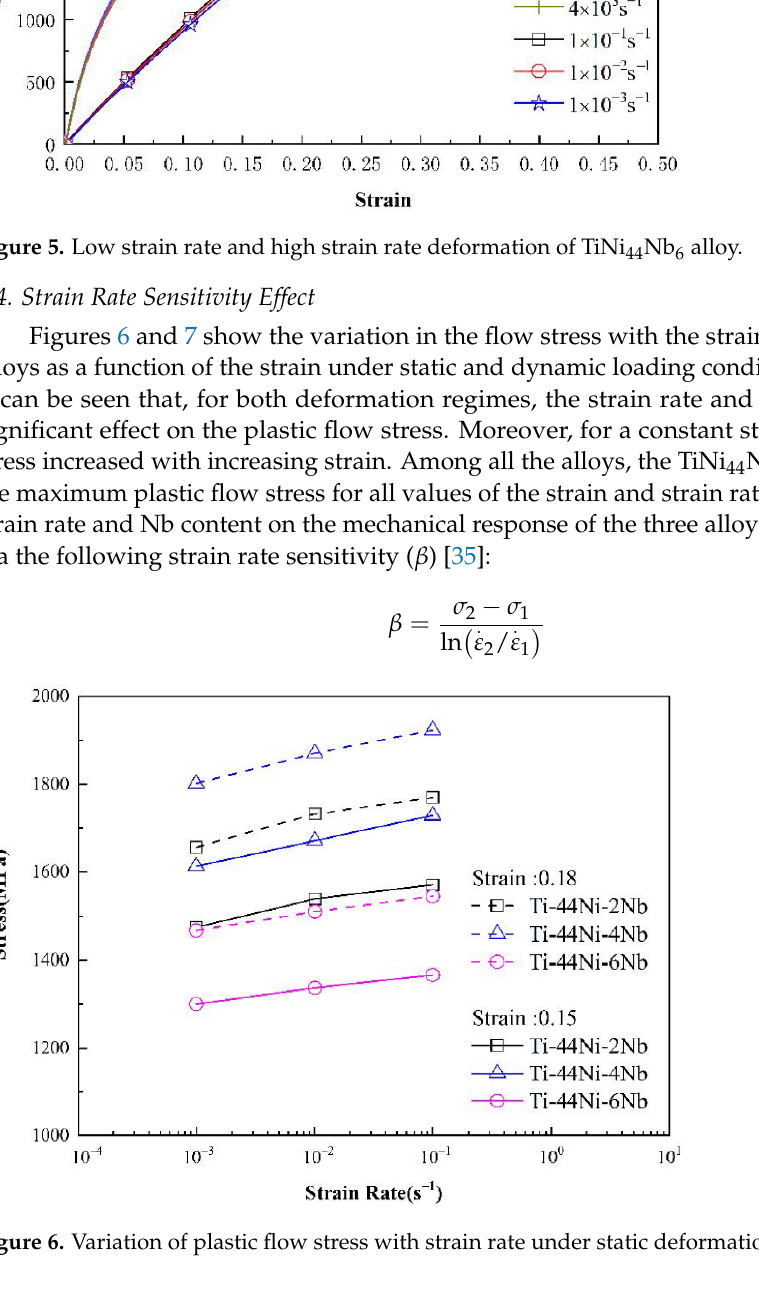
Figure 7. Variation of plastic flow stress with strain rate under dynamic deformation conditions.